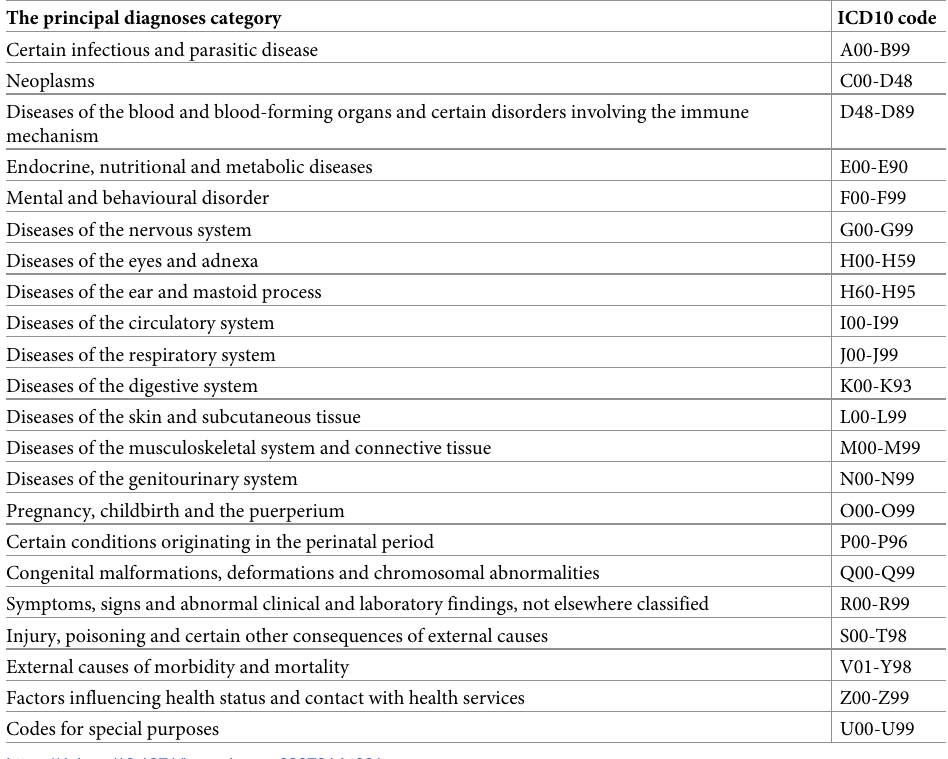
Table 1. The principal diagnoses category and ICD10